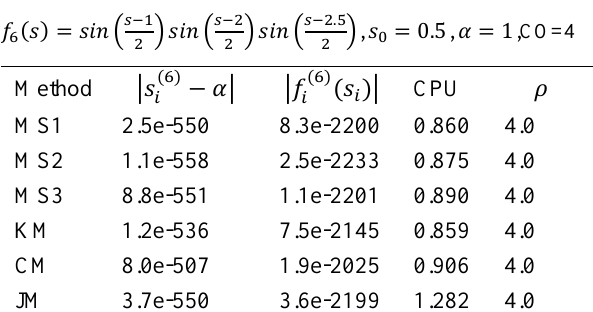
Comparison of single roots finding